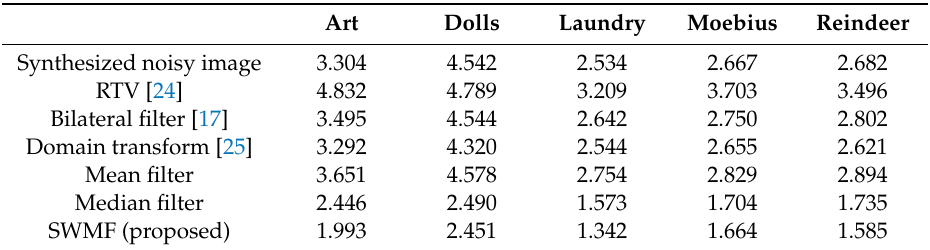
Table 1. Root-mean-square-error (RMSE)